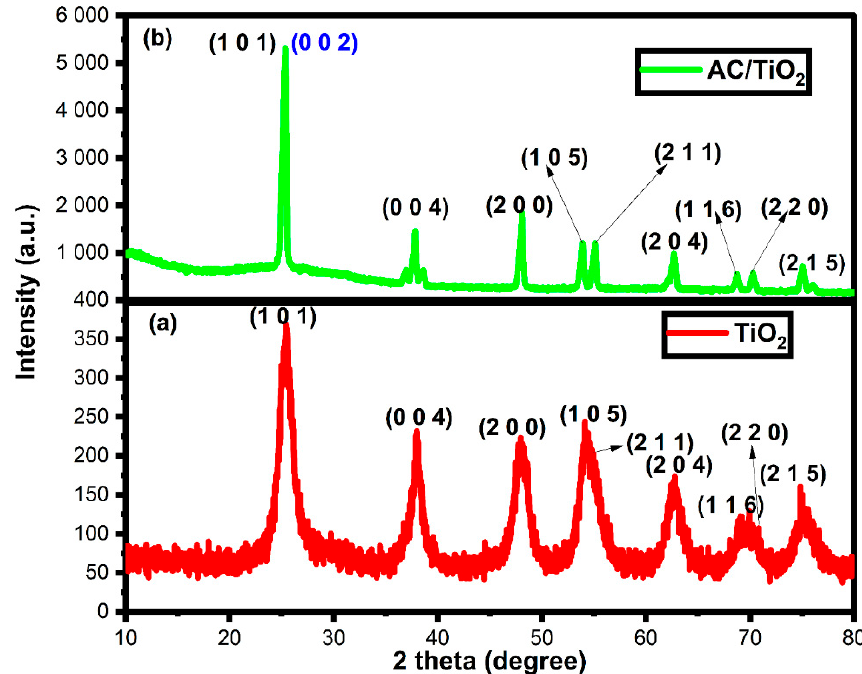
Figure 1. X-ray diffraction pattern of TiO 2 ( a ) and AC/TiO 2 ( b ) nanoparticles.